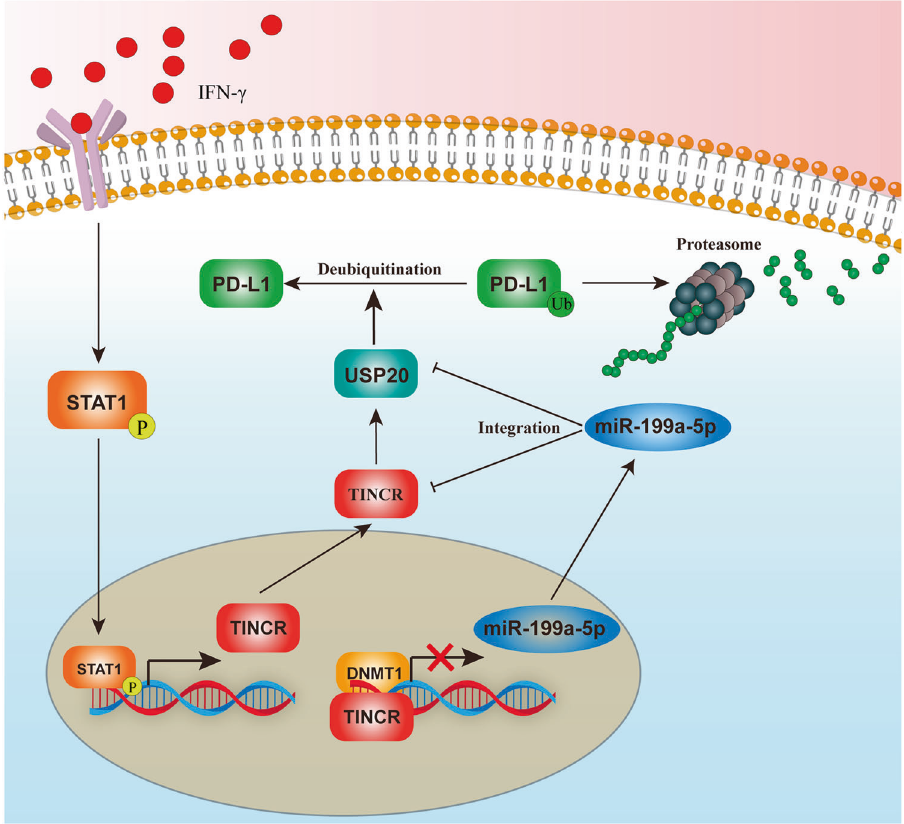
Fig. 7 Molecular mechanism of TINCR – USP20 – PD-L1 and their upstream regulation. IFN- γ upregulates the expression of TINCR by promoting the expression of STAT1, and the downstream genes, include USP20 and PD-L1, of TINCR via downregulating